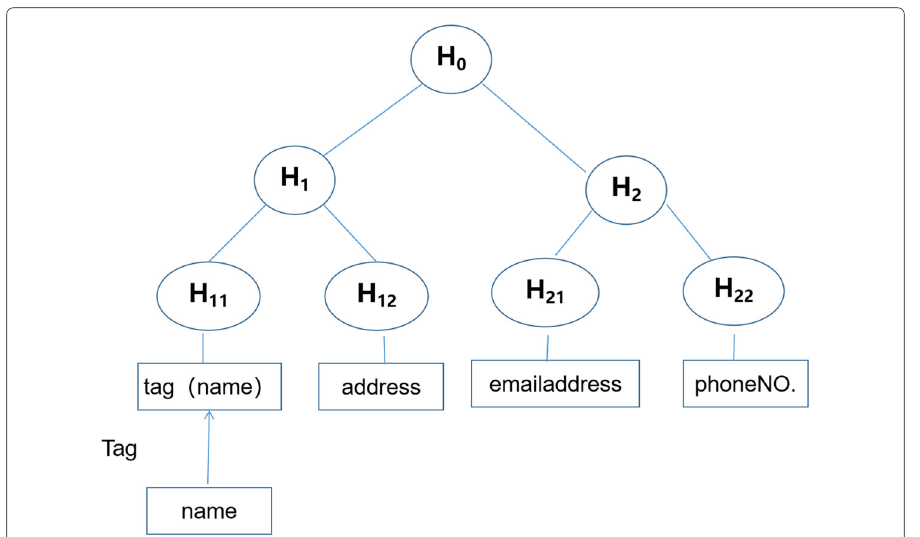
Fig. 4 The registration of user. Generate a value for each user by using Merkle